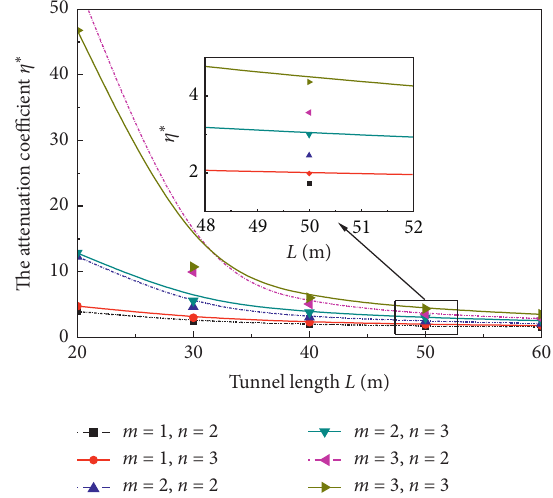
Figure 9: Relationship between attenuation and tunnel length for different modes, where η � 1.0 × 10 6 Pa · s.